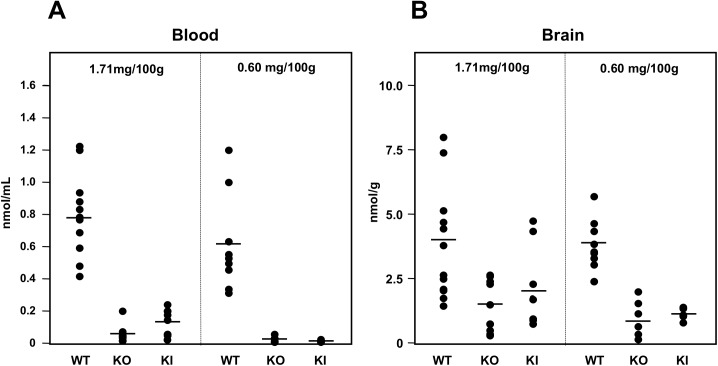
Thiamine concentrations in the blood and brain of WT, homozygous Slc19a3 KO, and Slc19a3 KI mice.Whole blood and cerebrum homogenates of KO and KI mice were obtained at 5 and 14 days of thiamine restriction, respectively. A. Thiamine concentration in whole blood (nmol/mL). B. Thiamine concentration in cerebrum homogenates (nmol/g wet weight). Bullets, individual thiamine concentrations; and bars, mean values.